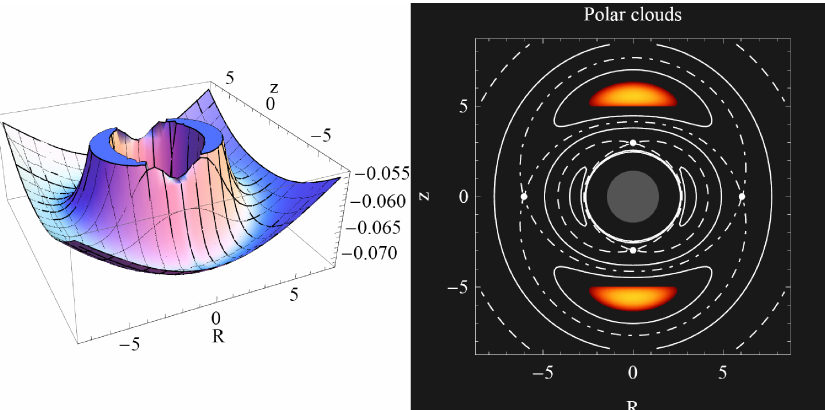
Figure 25. Typical behavior of the potential W for the charged fluid shown in terms of its poloidal profile and poloidal equipotential contours. The behavior characterizes circulation of the fluid with Ω = = kA , where k = 1.6 10 − 3 and 1.38, in the field with the parameters a = 0.9, B = 6.5 − × K − and Q = 3.99 10 − 3 . The twice self-crossing dot-dashed curve determines the pseudo-critical polar × lobes with the equatorial pseudo-cusps, corresponding to the equatorial saddle points, while the twice self-crossing dashed curve determines the critical polar lobes with the polar cusps, corresponding to the polar saddle points; the dots denote locations of the cusps and